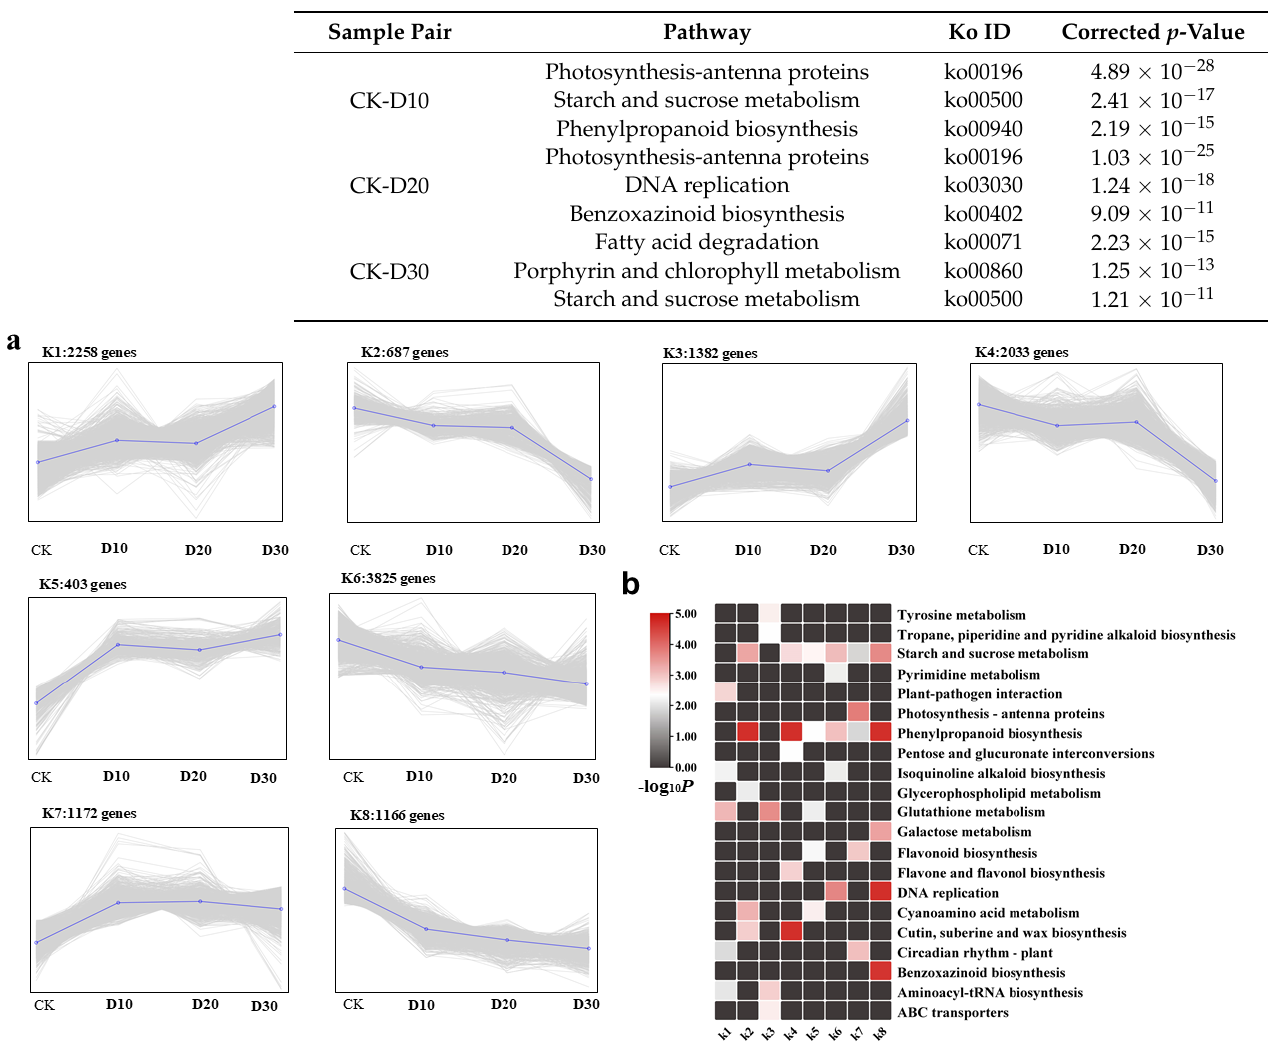
Figure 4. Hierarchical clustering was used to identify clusters of DEGs in the twelve libraries. ( a ) K - means clustering of DEGs. ( b ) Top fi ve enrichment pathways of the DEGs in di ff erent clusters with reference to KEGG.